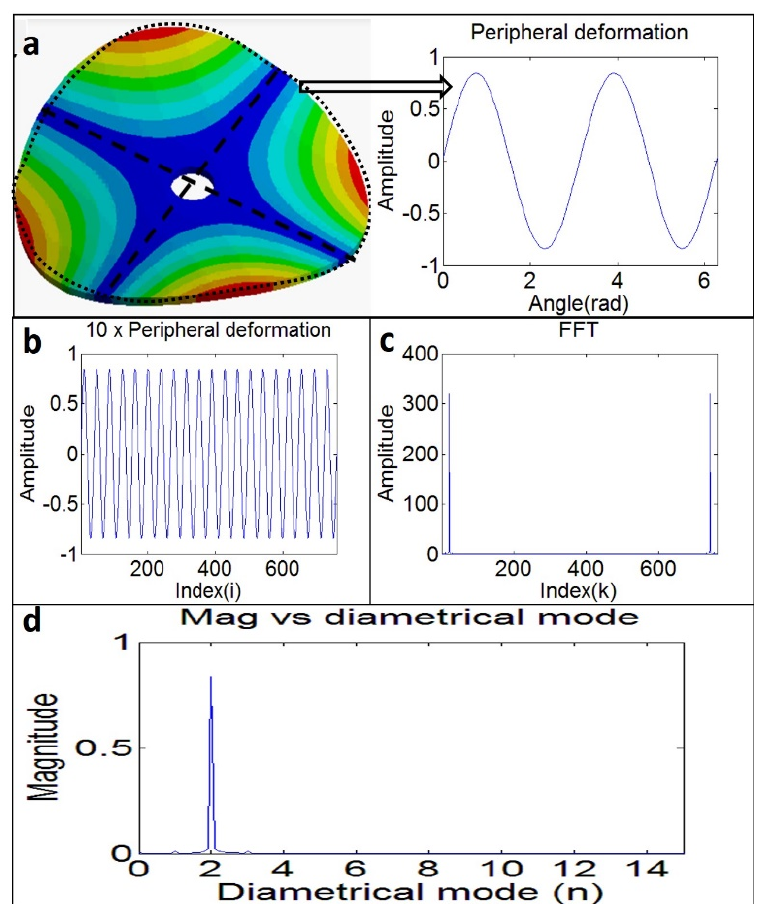
Figure 5. Procedure of mode shape decomposition: ( a ) Periphery of the disk, ( b ) Periphery elongated 10 times, ( c ) Magnitude after applying FFT algorithm, ( d ) Magnitude vs. Diametrical component.